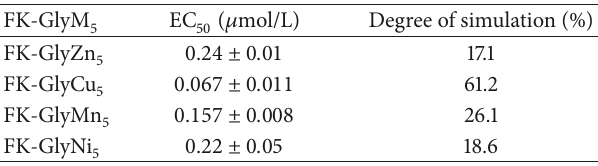
Figure 9: O 2∙− scavenging activity of FK-GlyM 5 . Table 5: EC 50 of FK-GlyM 5 .